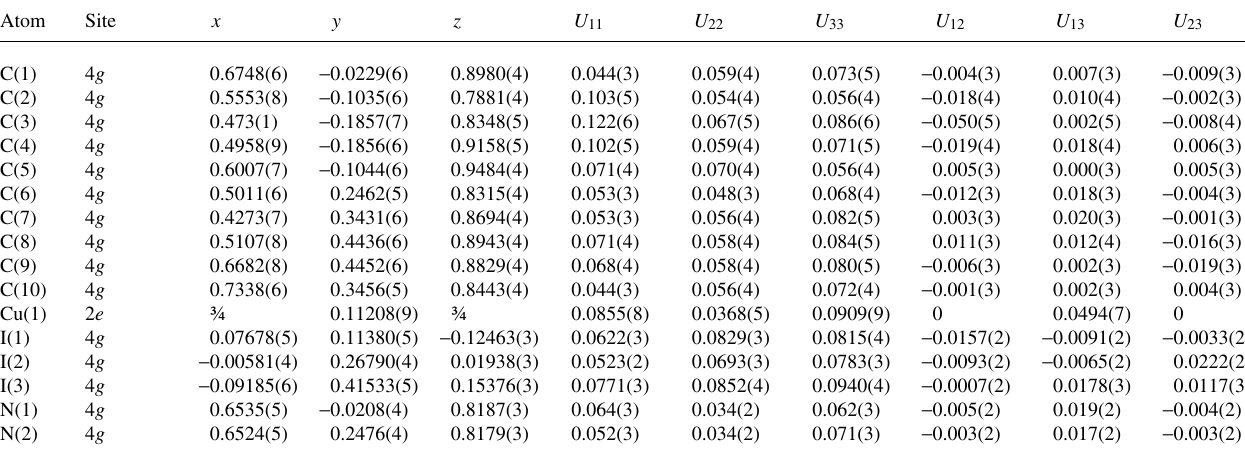
Table 3. Atomic coordinates and displacement parameters (in Å 2 )